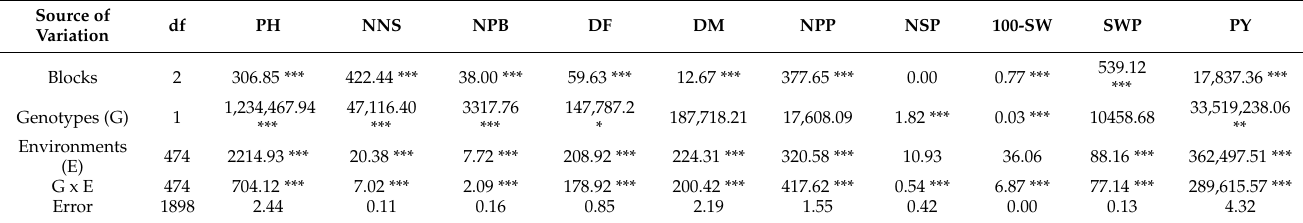
Table 2. Estimates of variance components for traits studied of adzuki bean